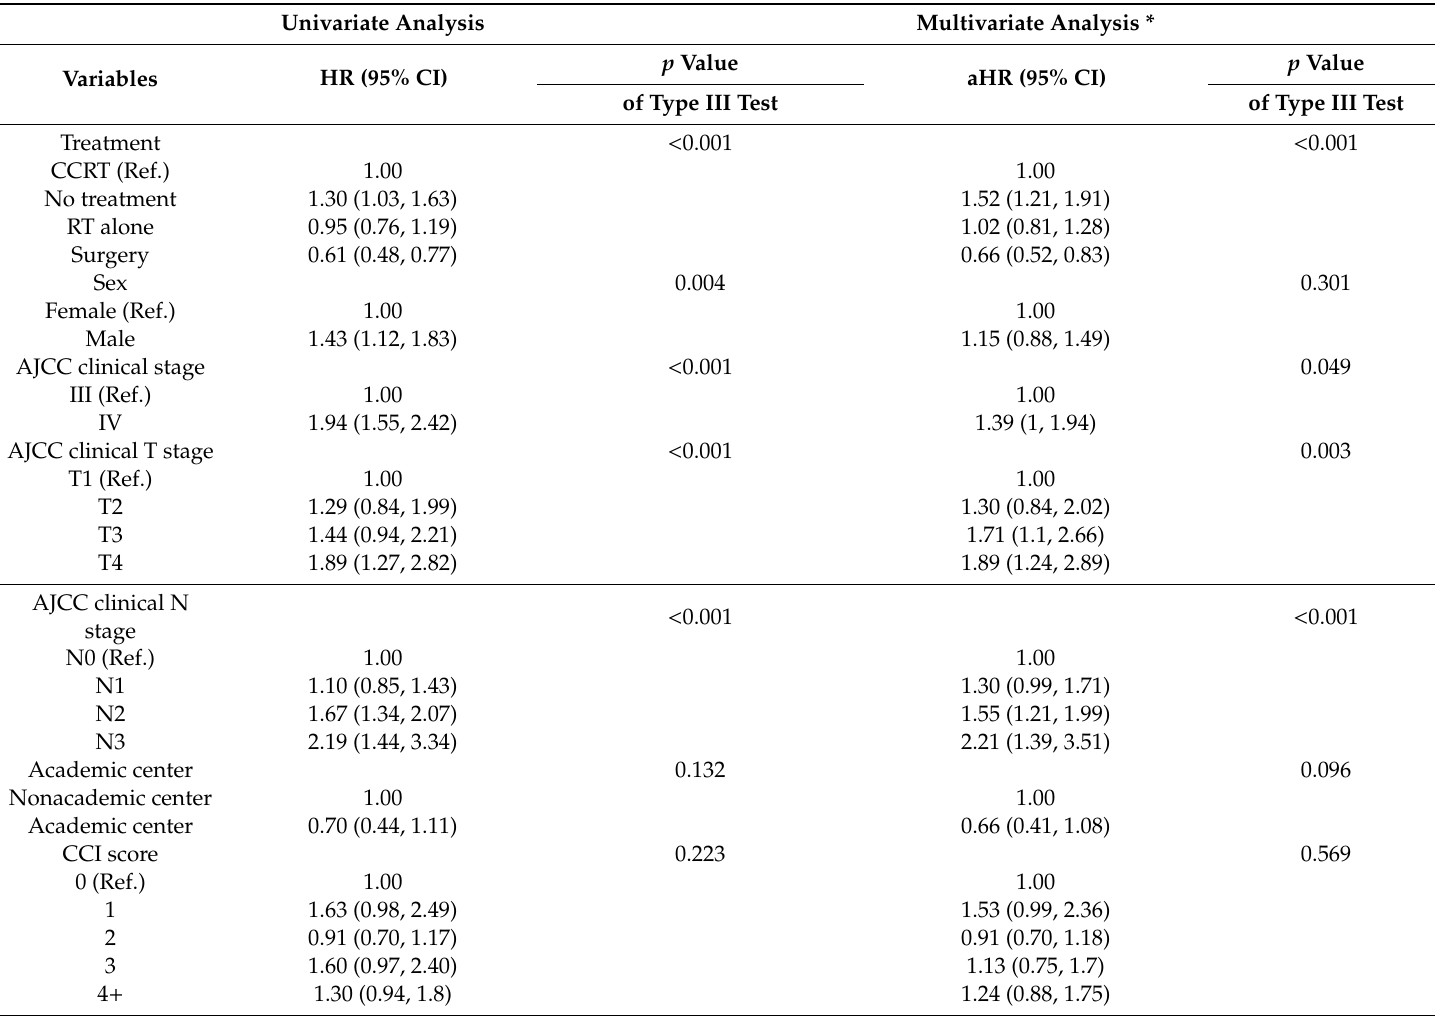
Table 3. Cox Proportional Hazards Model for Mortality Risk in Patients 70 to 80 Years Old with Locally Advanced Oral Cavity Squamous Cell